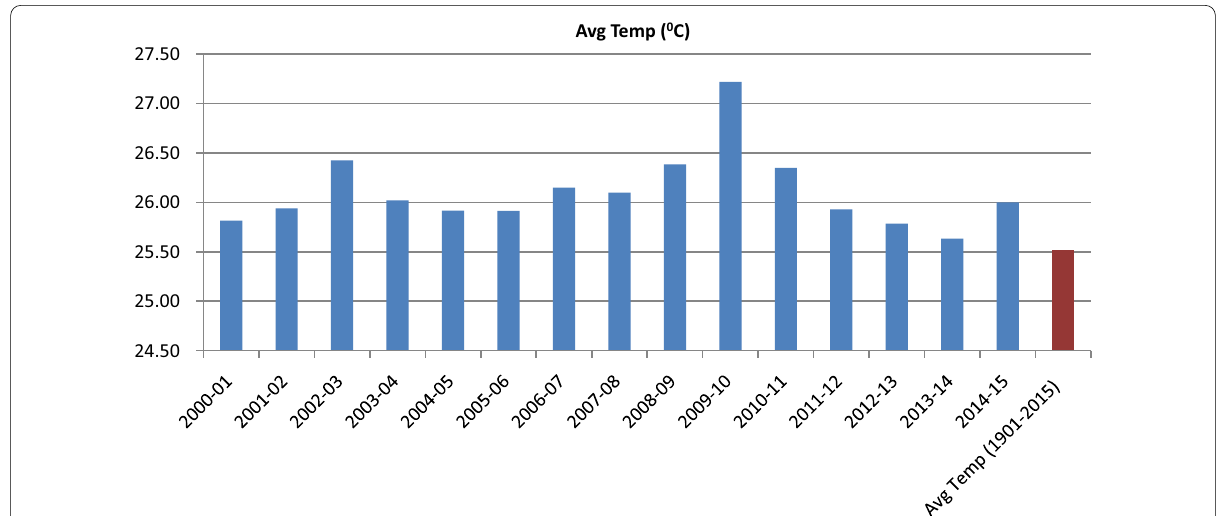
Fig. 26 Comparison of annual average temperature (°C) from 2000 to 2015 and its average during the study period